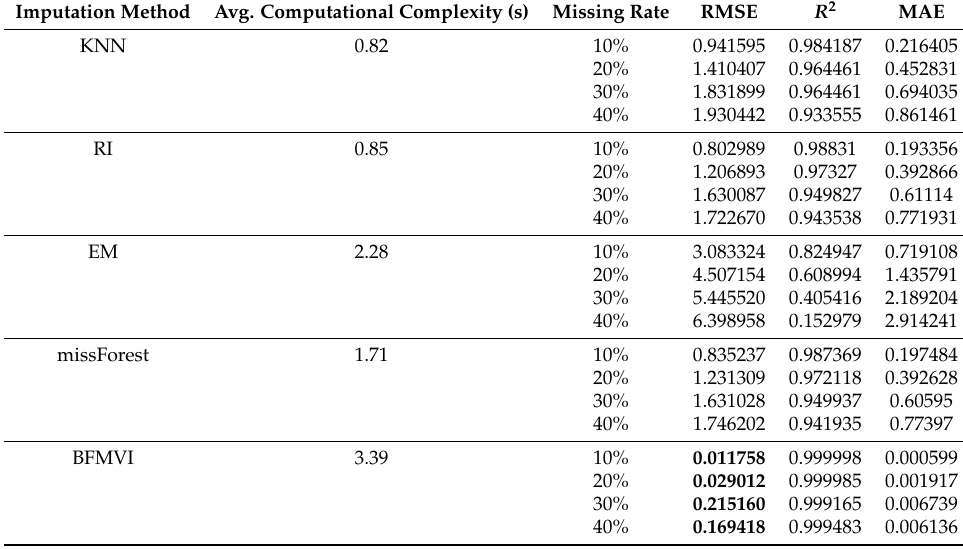
Table 1. Performance and computational complexity of imputation